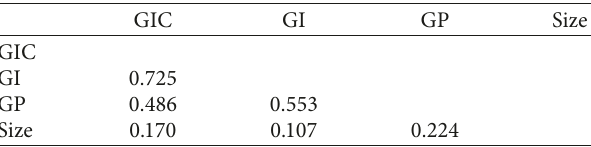
Table 5: Measurement model: discriminant validity.